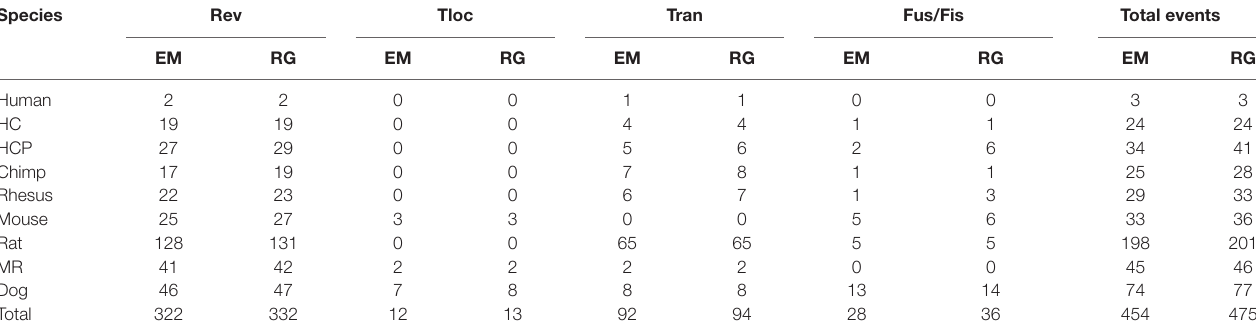
TABLE 4 | Genome rearrangement predictions of EMRAE and recovering the genome rearrangements based on phylogenetic tree at 50 kb resolution. Species Rev Tran Fus/Fis